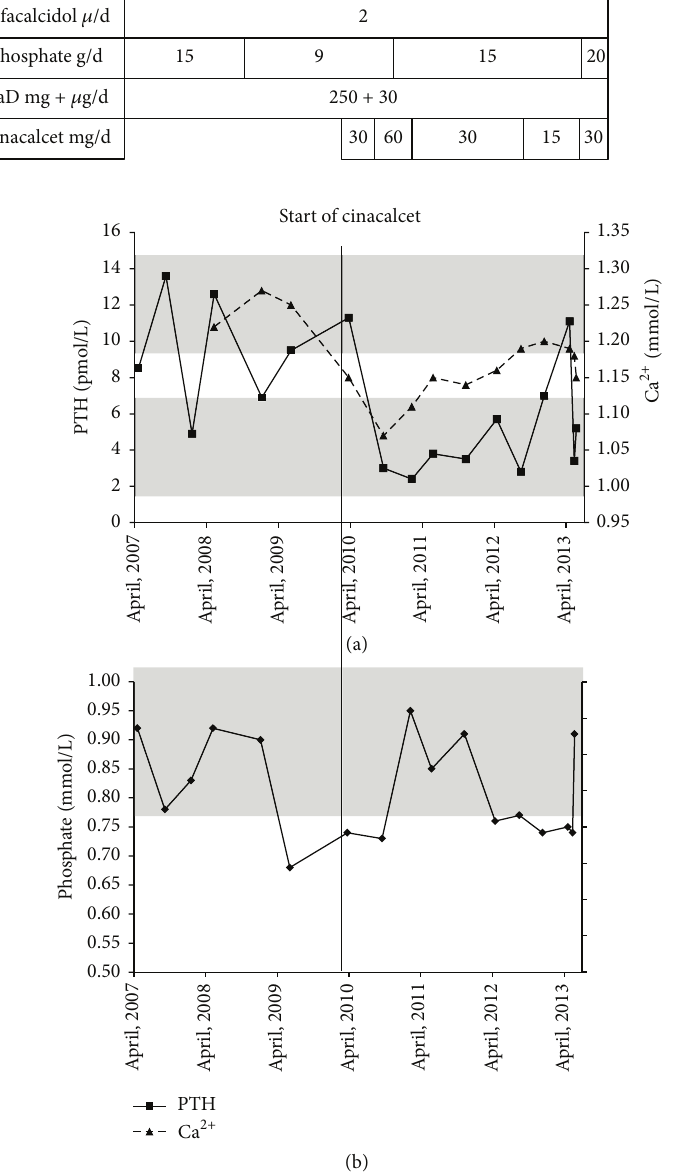
Figure1:PlasmalevelsofPTH,ionized-calcium(Figure 1(a)),andphosphate(Figure 1(b))threeyearsbeforeinitiationofcinacalcettreatment and during the three years of cinacalcet treatment. Start of cinacalcet treatment, as indicated by the vertical line, was March 2010. Top bars show dosage of medical treatment. CaD; calcium carbonate 250 mg with 30 𝜇 g/d (1200 IU) of cholecalciferol. Reference intervals of plasma PTH (1.6–6.9 pmol/L) are indicated by the lower grey area and plasma Ca 2+ (1.18–1.32mmol/L) by the upper grey area. Measurements of ionized calcium (Ca 2+ ) were not available prior to May 2008 (Figure 1(a)). The reference interval of plasma phosphate was 0.76–1.41 mmol/L, as indicated by the grey area (Figure